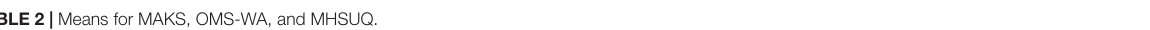
TABLE 2 | Means for MAKS, OMS-WA, and